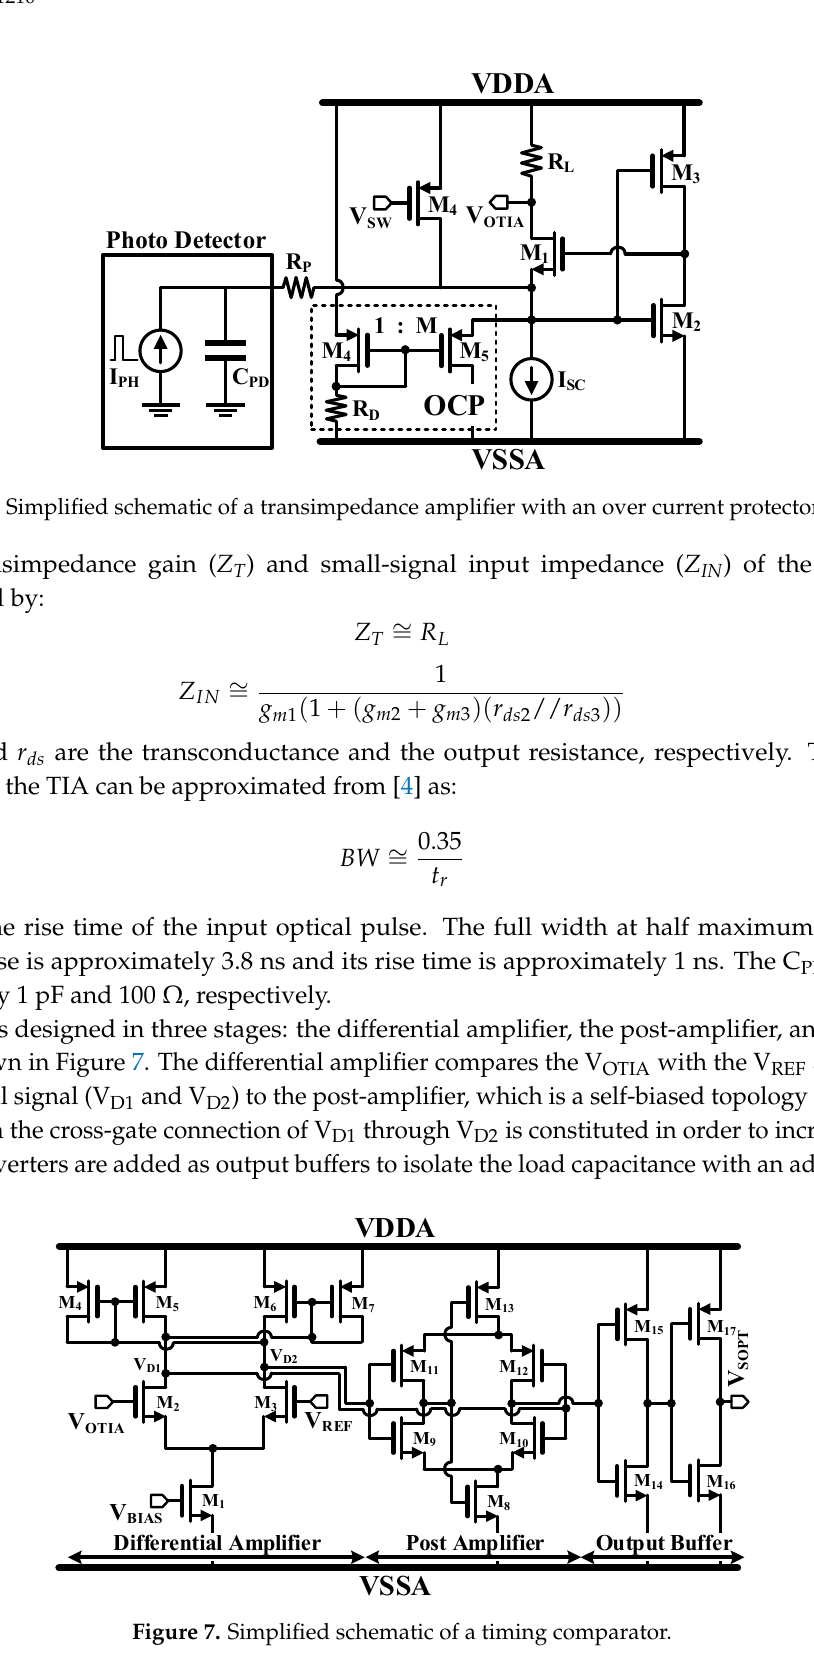
5 Figure 4. Data readout timing of ( a ) a conventional and ( b ) the proposed LADAR receiver. A simplified operational timing diagram of the FPA-based LADAR system, employing the proposed digital-assisted readout scheme, is illustrated in Figure 5. When the chip is enabled by Ø CEN , the master clock of 40 MHz (Ø MC ) starts to trigger the synchronization of all the operational circuits on the chip. The proposed readout scheme utilizes all the operational periods (T FR ) by inserting additional detection periods (T SF ) into the waste time, resulting in three sub-frames (T ED , T SF1 , and T SF2 ) for multiple echo detection. Each sub-frame is activated with reset signal triggering (Ø RST ) during T FR . Within each sub-frame, if the returned echo is found during the timing detection period (T TD ), its range information is stored in the S/H RD with the triggering of the range register (Ø REGR ). At the same time, the echo intensity detection is performed, and its intensity information is stored in the S/H IT at the rising edge of the intensity register (Ø REGI ). During the data readout period (Ø DR ), each row of the FPA is activated in sequence with row readout triggering (Ø RA ), and all the columns in the selected row are read by the sequential column activation of the V-scanner with column readout triggering (Ø CA ), as in the serial data readout. Ø CEN Ø RST Ø Ø REGI Ø RA Ø CA Ø ST T TD3 Ø MC Ø DR Figure 5. Operational timing diagram of the prototype FPA-based LADAR. In this work, the TIA has a regulated cascode (RGC) topology based on inverter local feedback for a low input impedance, resulting in wider bandwidth [8], as shown in Figure 6. Here, VDDA indicates the supply voltage and VSSA indicates the ground voltage for the TIA circuit operation. In